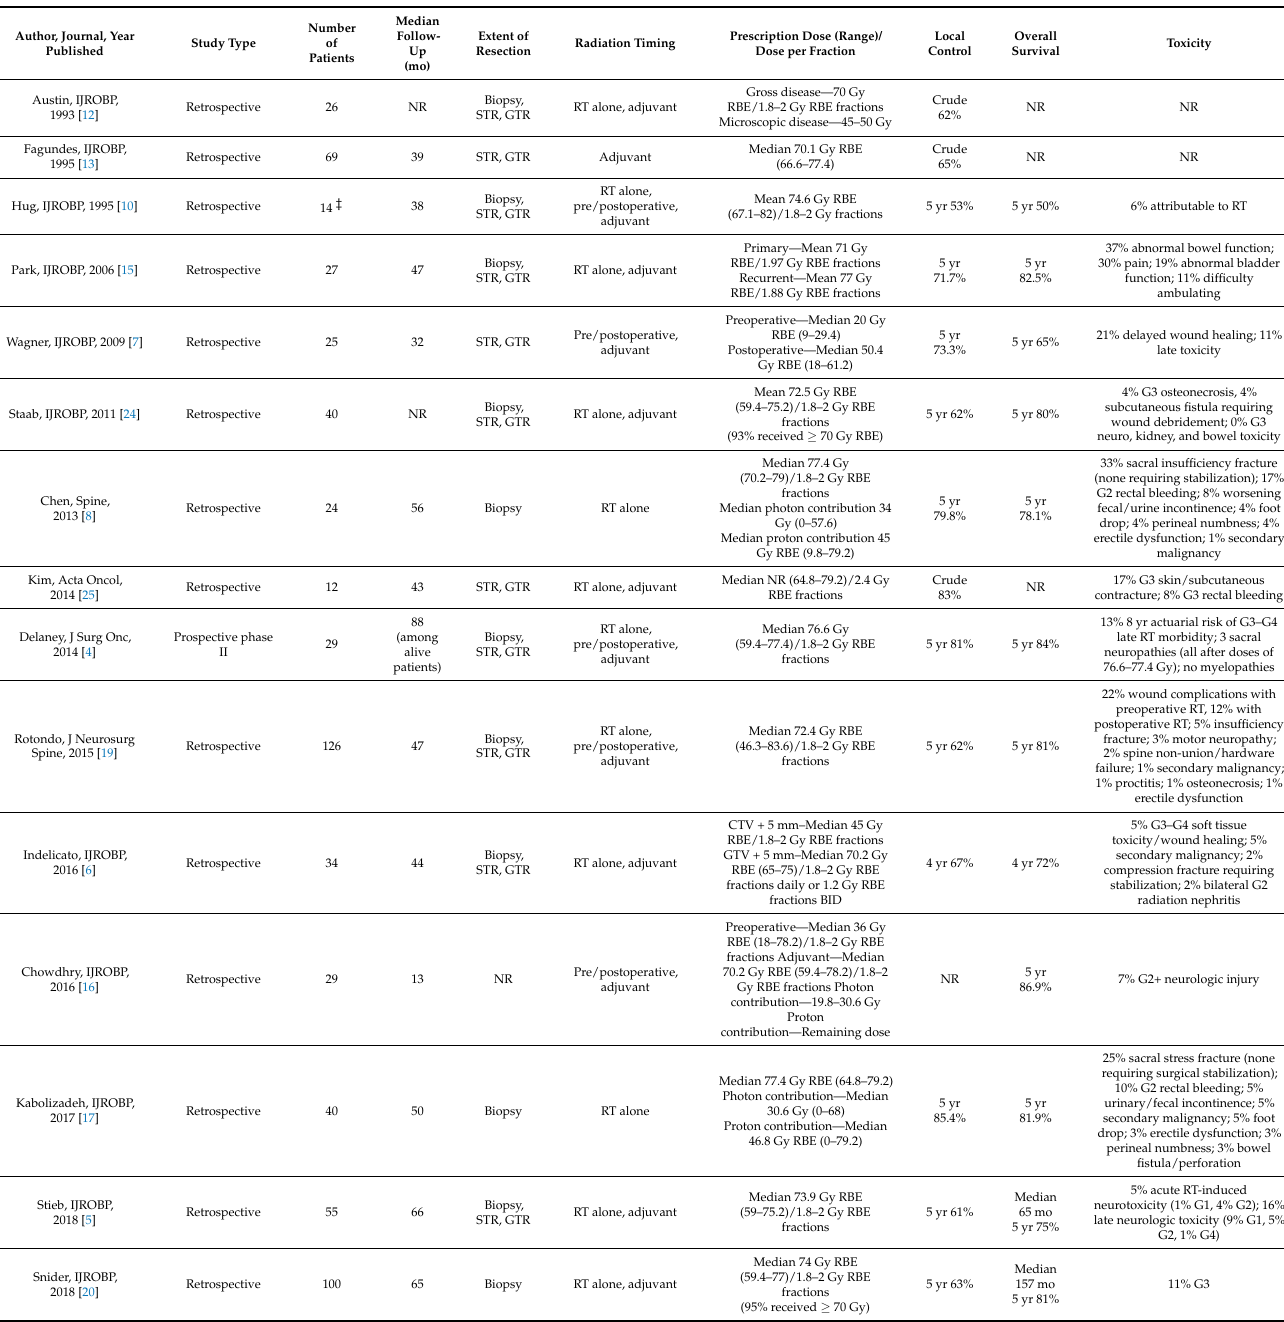
Table 1. Data summary of studies reporting outcomes of patients with spinal and sacral chordomas treated with proton